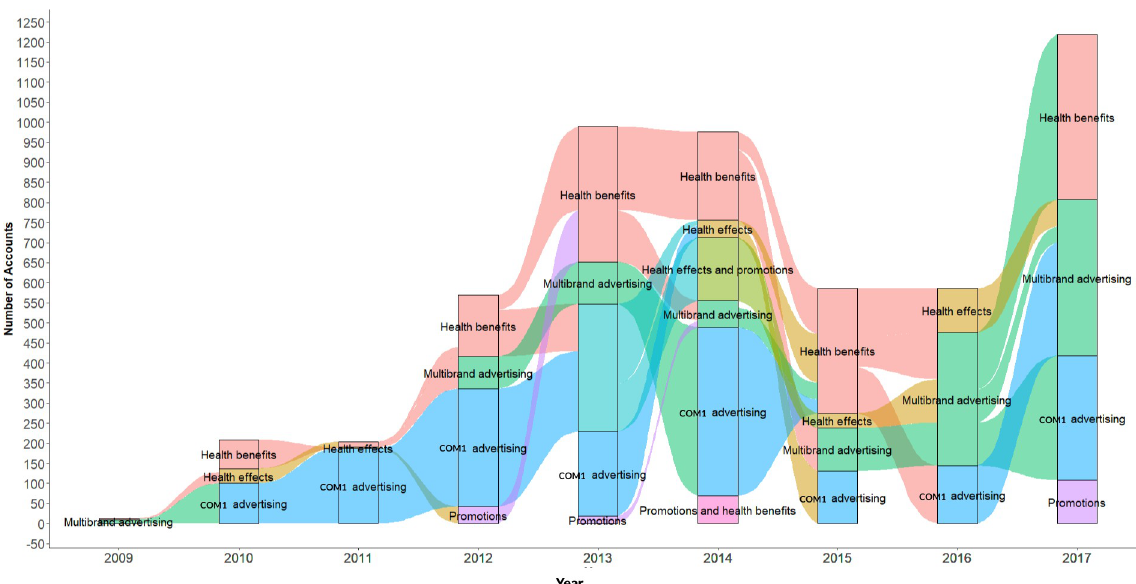
Fig 3. Alluvial diagram showing the variations in online probiotic community themes on Twitter from 2009–2017. Each coloured block represents a theme with the stream fields showing how the respective themes varied from one year to the next. There are total of five themes across the nine year period. All the five themes were noticed for the years 2013 an 2014. Health Benefits, COM1 Advertising and Multibrand Advertising are the most popular themes.